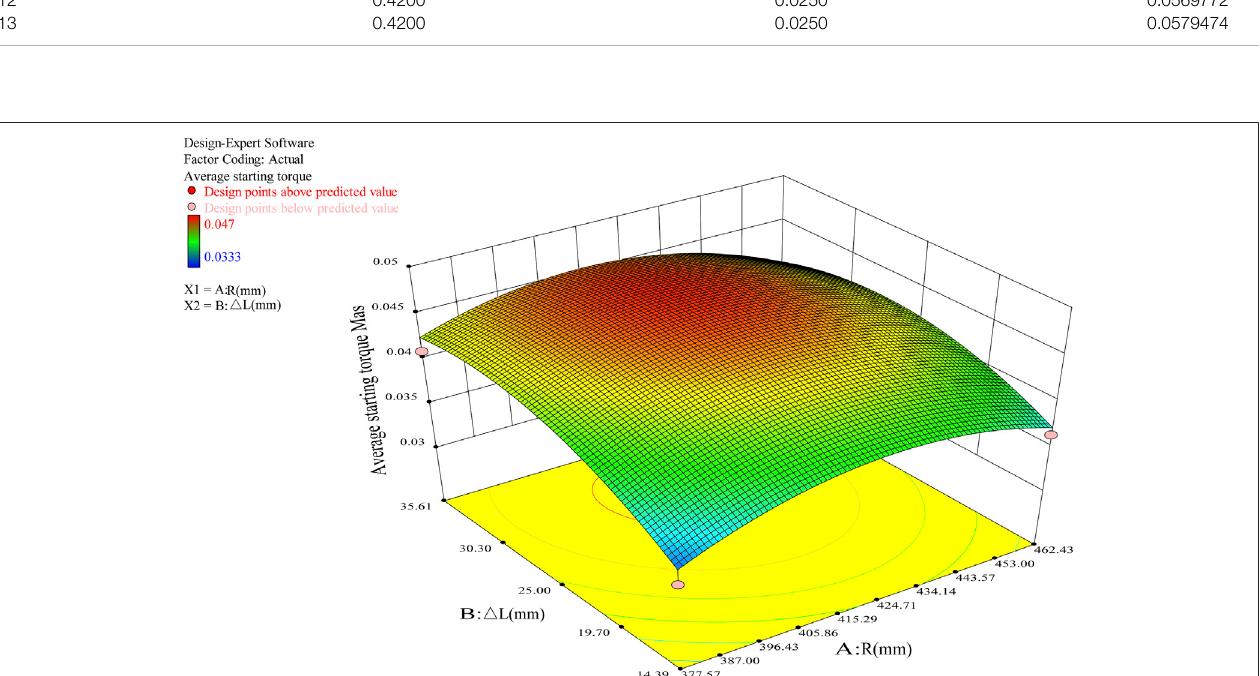
FIGURE 4 | Response